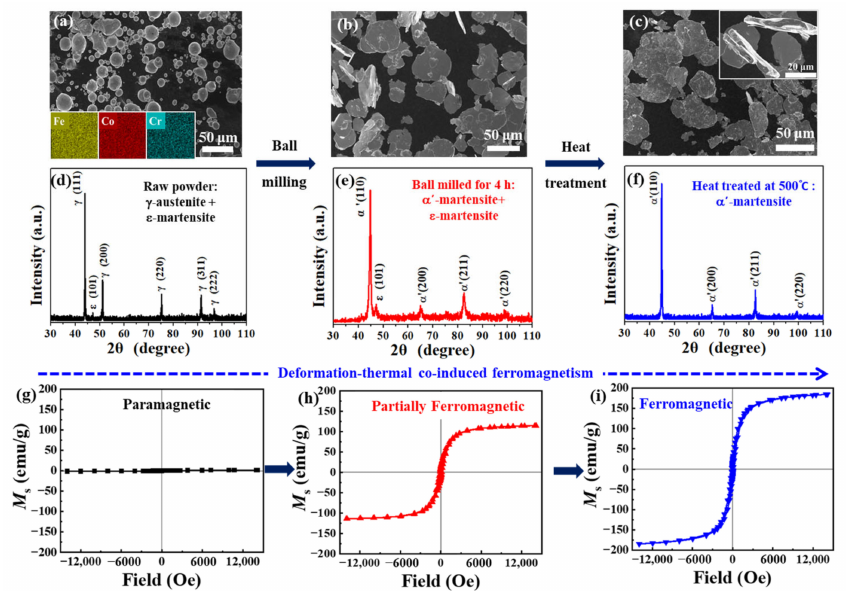
Figure 1. SEM images, XRD spectra and hysteresis loops of ( a , d , g ) raw FeCoCr powders, ( b , e , h ) those after ball milling for 4 h, and ( c , f , i ) subsequent heat treatment at 500 ◦ C. Insets in ( a ) is the energy dispersive X-ray spectroscopy images for element distribution, while that in ( c ) is the SEM image for lateral view of FeCoCr